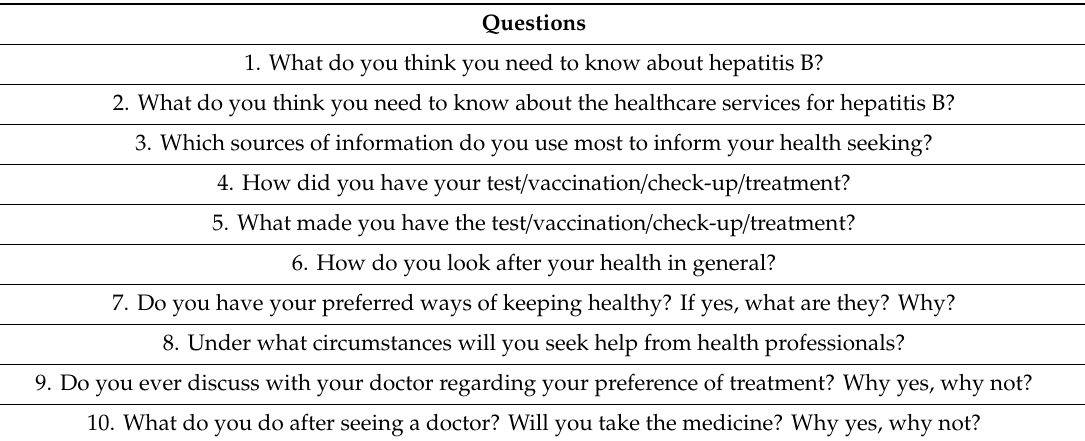
Table A2. The open-ended interview with key